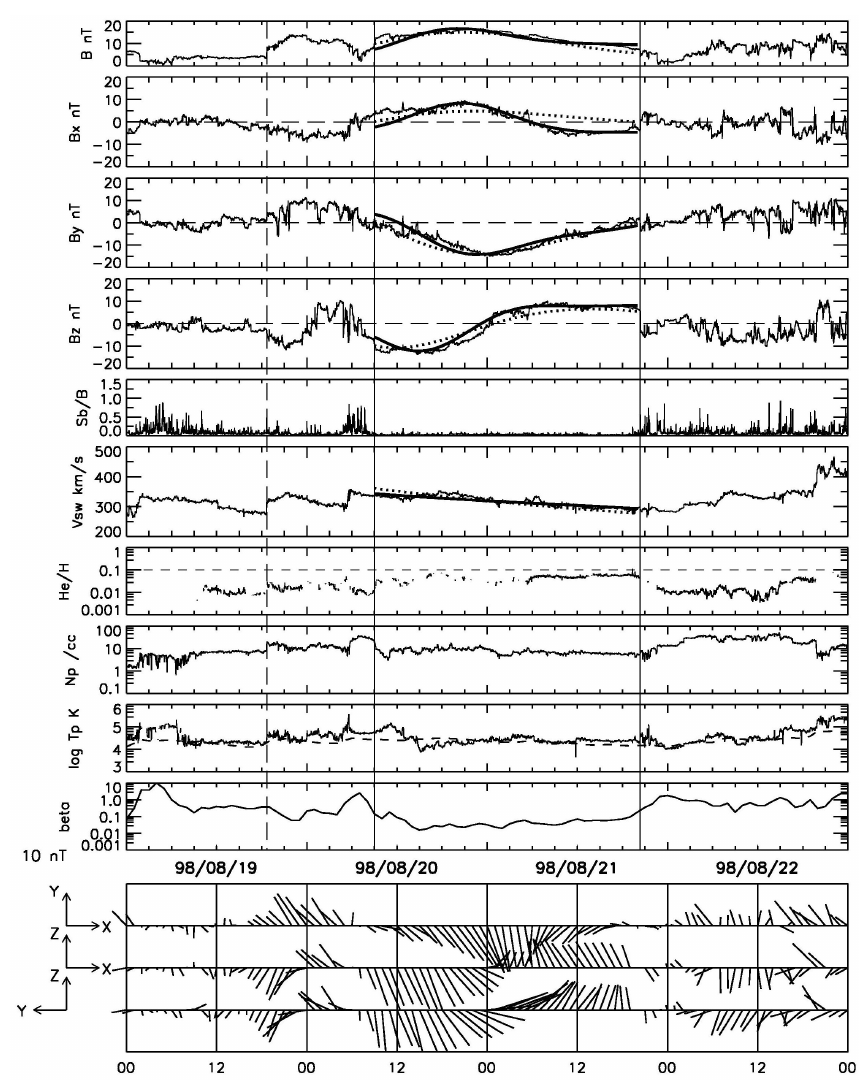
Fig. 12. Results of the fitting with the torus model (solid curve) and with the cylinder model (dotted curve) to the magnetic cloud (MC) encountered on 20 August 1998 (Event 10) in the same format as Fig. 4. The bottom three panels show the projected magnetic field